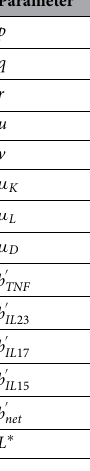
Table 1. Parameters and their default